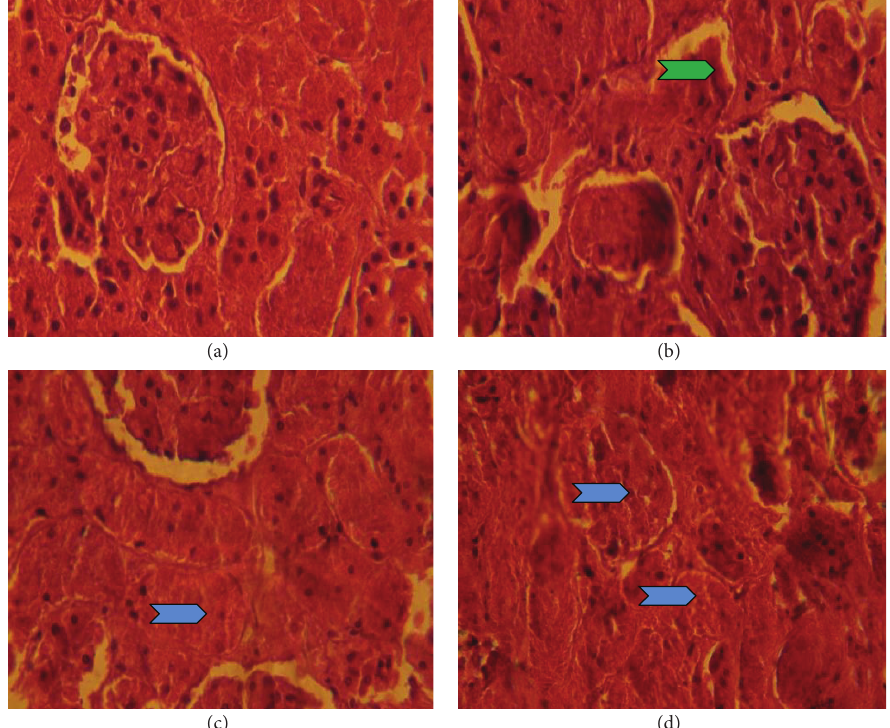
Figure 5: Influence of 2,5-HD on kidney morphology after treatment for 21 consecutive days in rats. Representative photomicrographs of control (a) show normal renal architecture. Kidney histology revealed progressive degeneration of the proximal tubules characterized by mild hemorrhage (green chevron) at interstitium in tubular epithelial cells in 0.25% 2,5-HD (b) and severe vacuolation and renal tubular necrosis (blue chevron) in 0.5% 2,5-HD (c) and 1% 2,5-HD